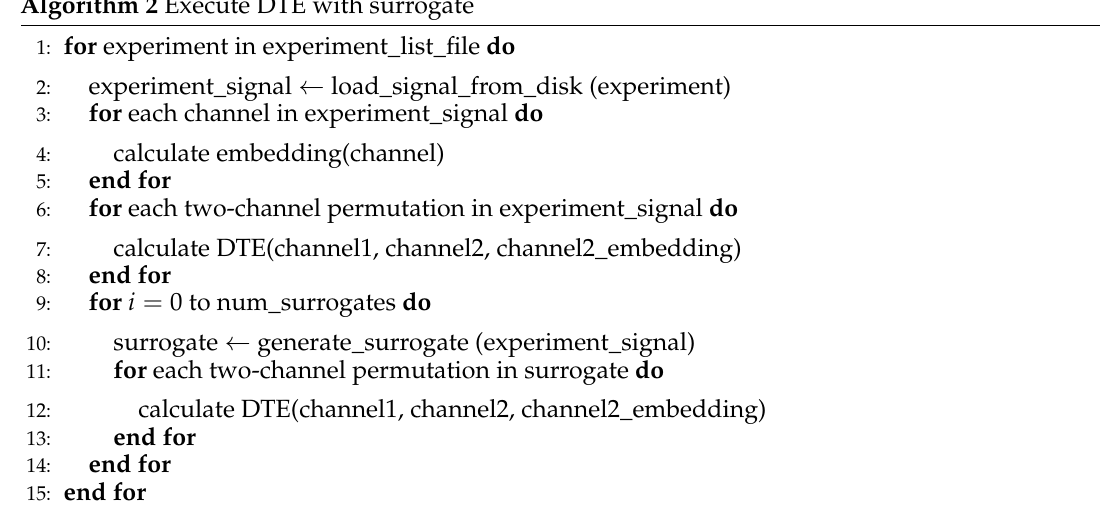
Algorithm 2 Execute DTE with